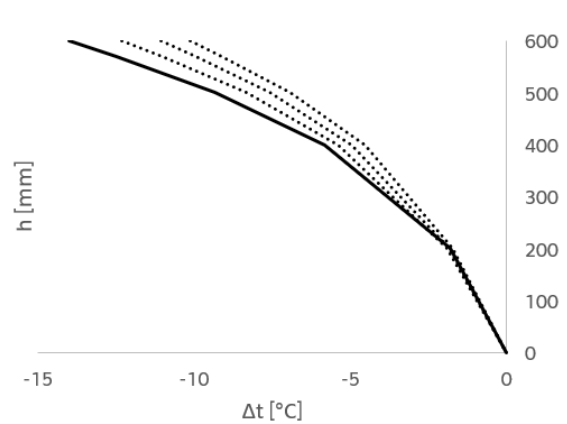
Figure 7. Horizontal temperature difference in abut- ment shaft.